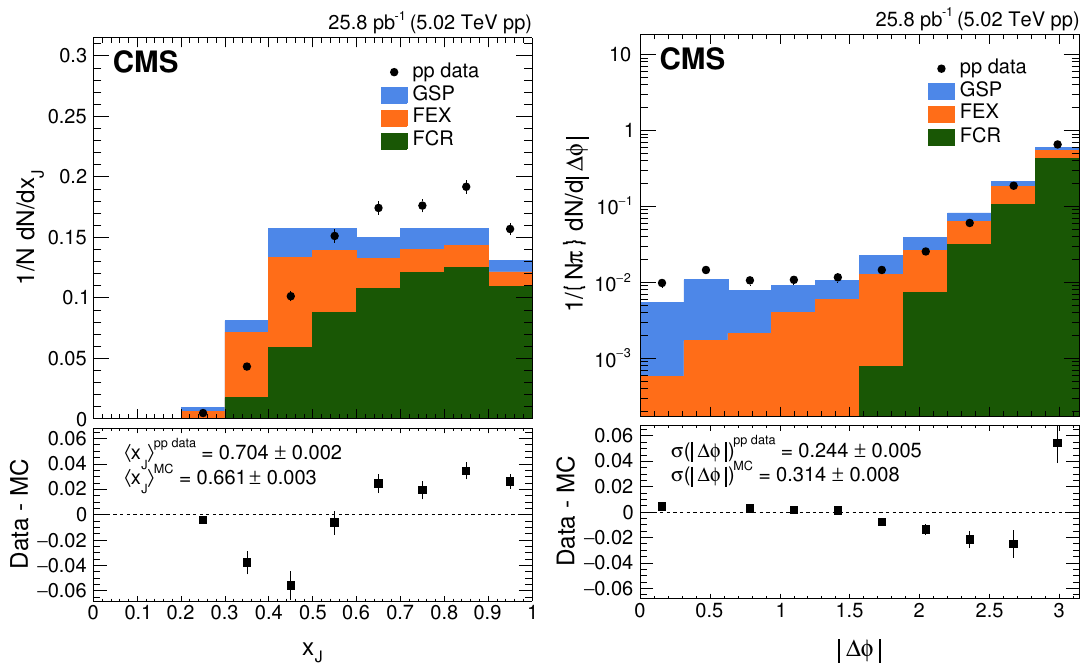
Figure 7 . The distributions of x J (left) and (cid:1) (cid:30) (right) in pp collisions before (cid:13)avor process reweighting. Data are shown in solid points, while the stacked histograms show the contributions of di(cid:11)erent processes in pythia 6 (see text for details). The bottom set of panels show the di(cid:11)erence between data and simulation